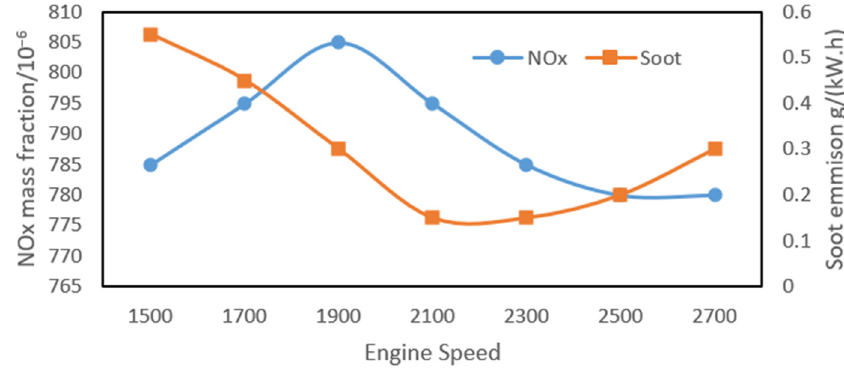
Figure 9. Emissions of scheme 1 at different speeds.